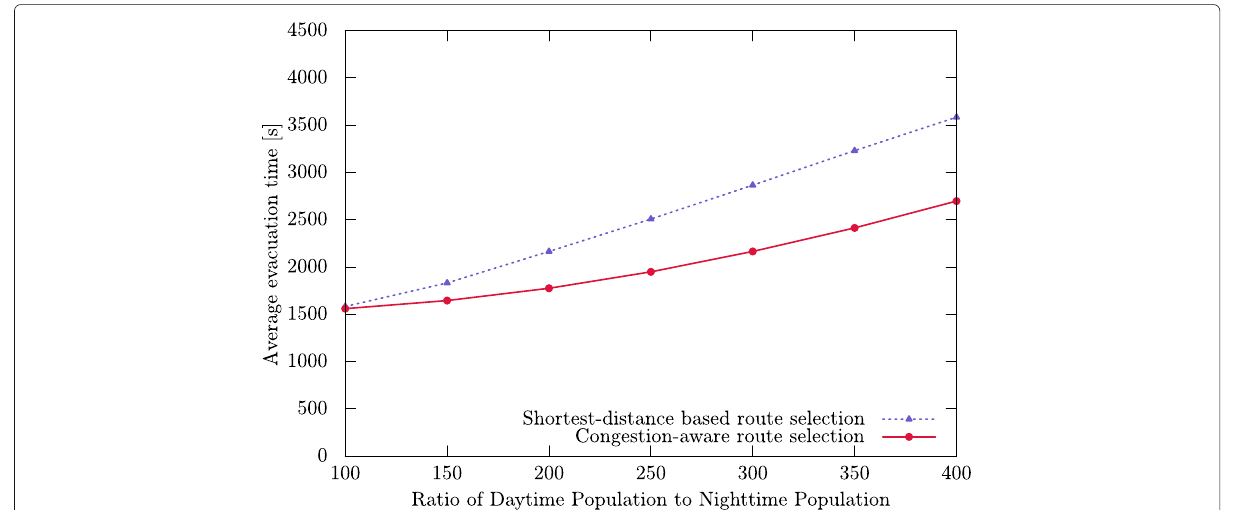
Fig. 7 The ratio of daytime population to nighttime population vs. average evacuation time (global scenario)